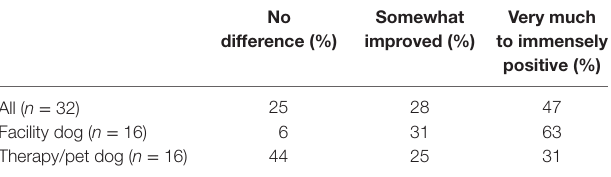
TaBle 2 | Percentage of interviewers reporting dogs changed their work stress.